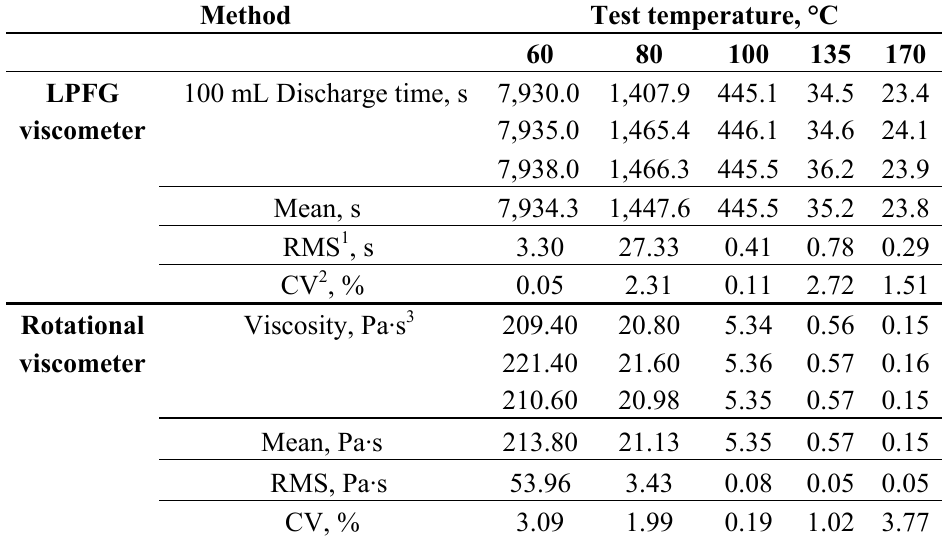
Table 1. Experimental data of LPFG-based and rotational